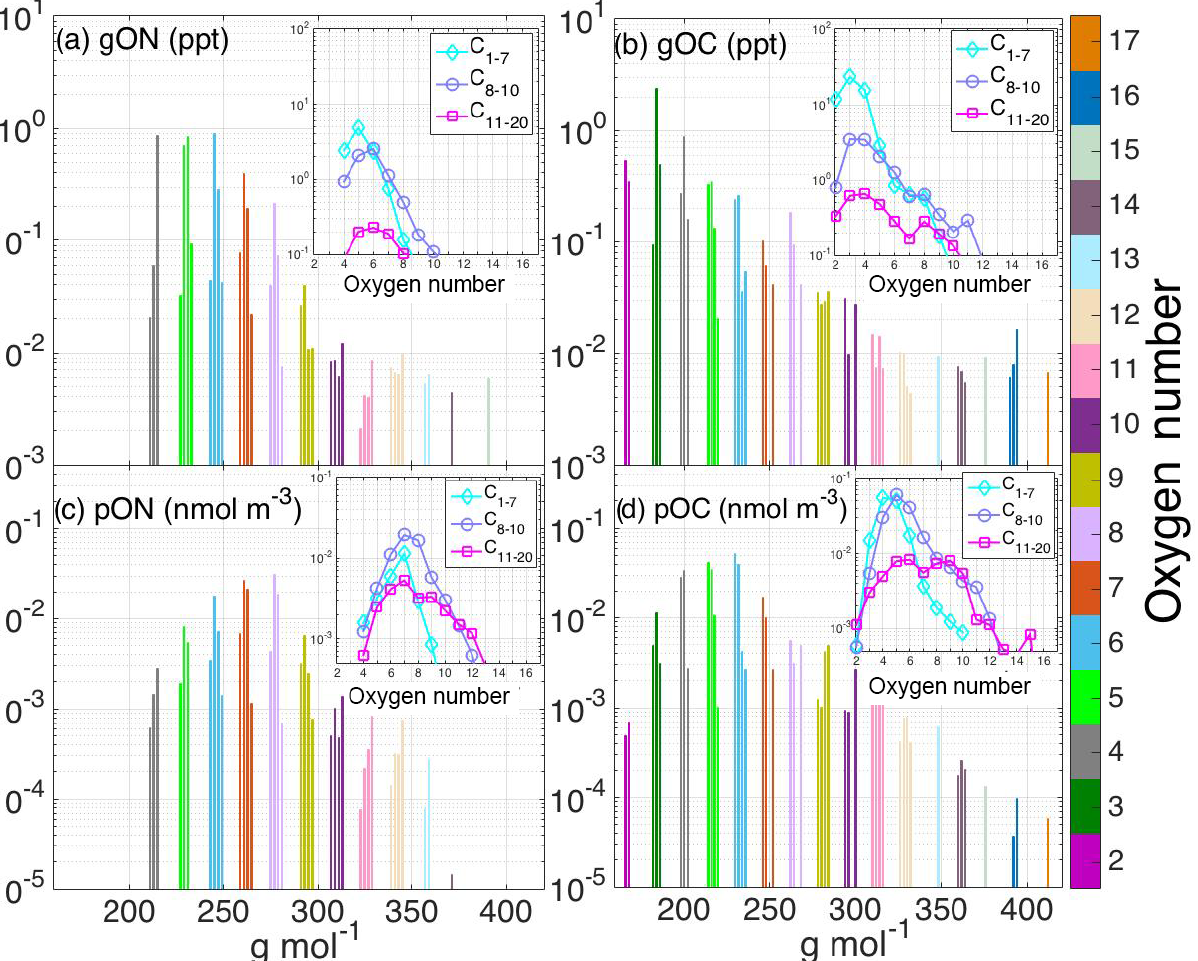
Figure 3. BAECC-median abundances of (a) gaseous ON, (b) gaseous OC, (c) particulate ON, and (d) particulate OC species possessing 10 carbon atoms, as a function of their molecular weights. Colors denote the oxygen atom number of each species. Gas-phase abundance gener- ally decreased with increasing molecular weight, whereas the particle phase exhibited an approximate bell-shaped distribution in abundance. The insets in each panel show the campaign median abundances accounted for by species with 1 to 7, 8 to 10, and 11 to 20 carbon atoms, plotted as a function of their oxygen atom